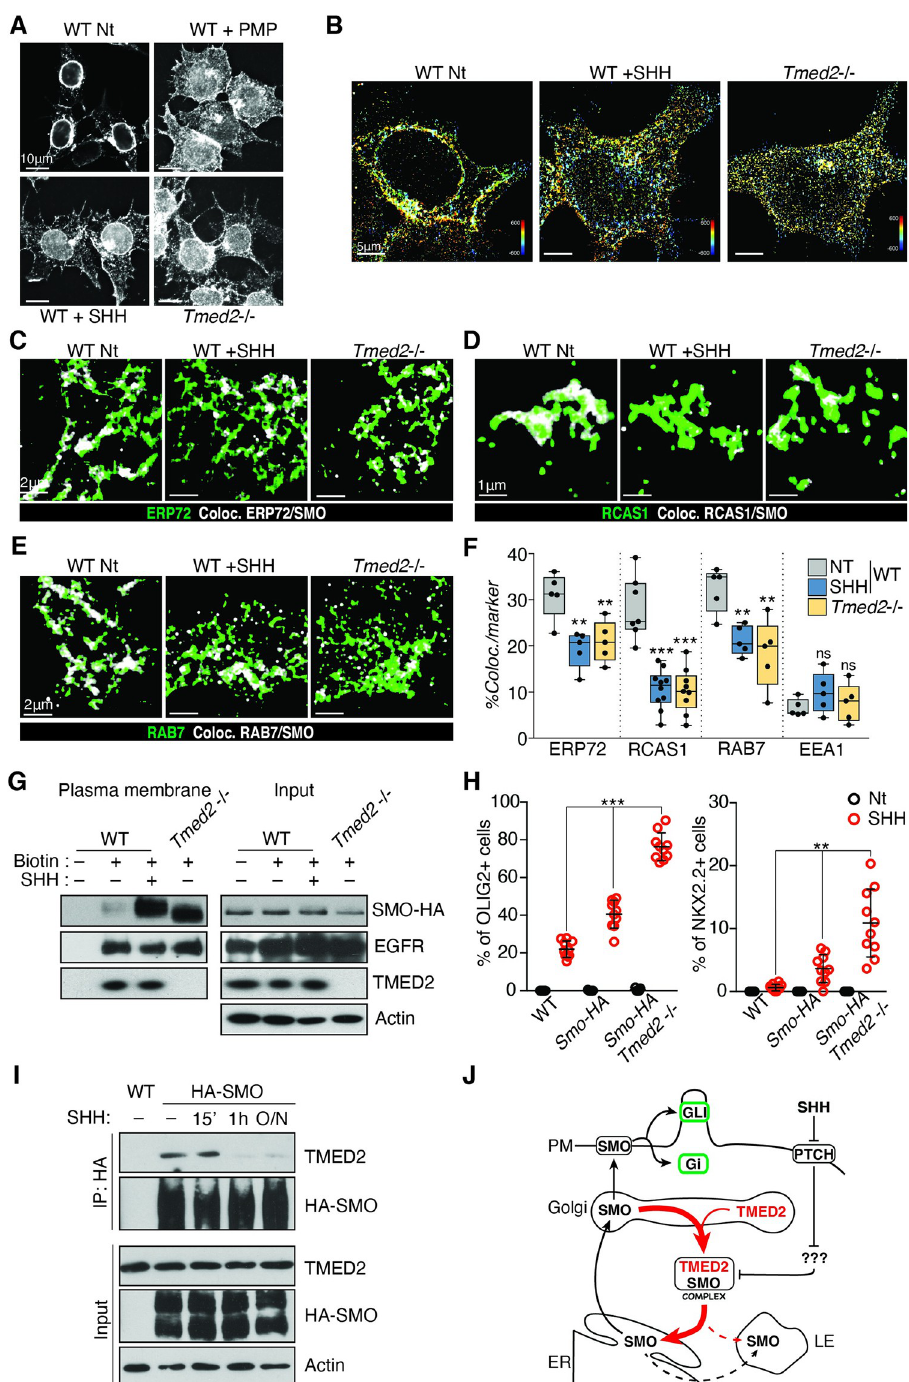
Fig 7. TMED2 regulates SMO abundance at the PM in a SHH-dependent manner. (A, B) Activation of HH signaling promotes SMO cellular redistribution. (A) FM images of SMO–HA in WT NPCs treated for 24 hours with PMP or SHH and in Tmed2 −/− cells. Scale bar = 10 μ m. (B) Three-dimensional color distribution of HA–SMO in 3D-STORM experiments performed in WT NPCs treated with SHH for 24 hours and in Tmed2 −/− NPCs. Scale bar = 5 μ m. (C–F) SHH treatment and Tmed2 mutation promotes SMO trafficking form ER–Golgi compartments. Dual color 3D-STORM analysis showing ERP72 (C), RCAS1 (D) and RAB7 (E) distribution in green and the SMO colocalizing domains in gray. (F) Plot showing percentage of SMO–HA colocalizing events normalized to marker distribution upon SHH treatment and Tmed2 mutation. Asterisks denote statistical significance for difference from